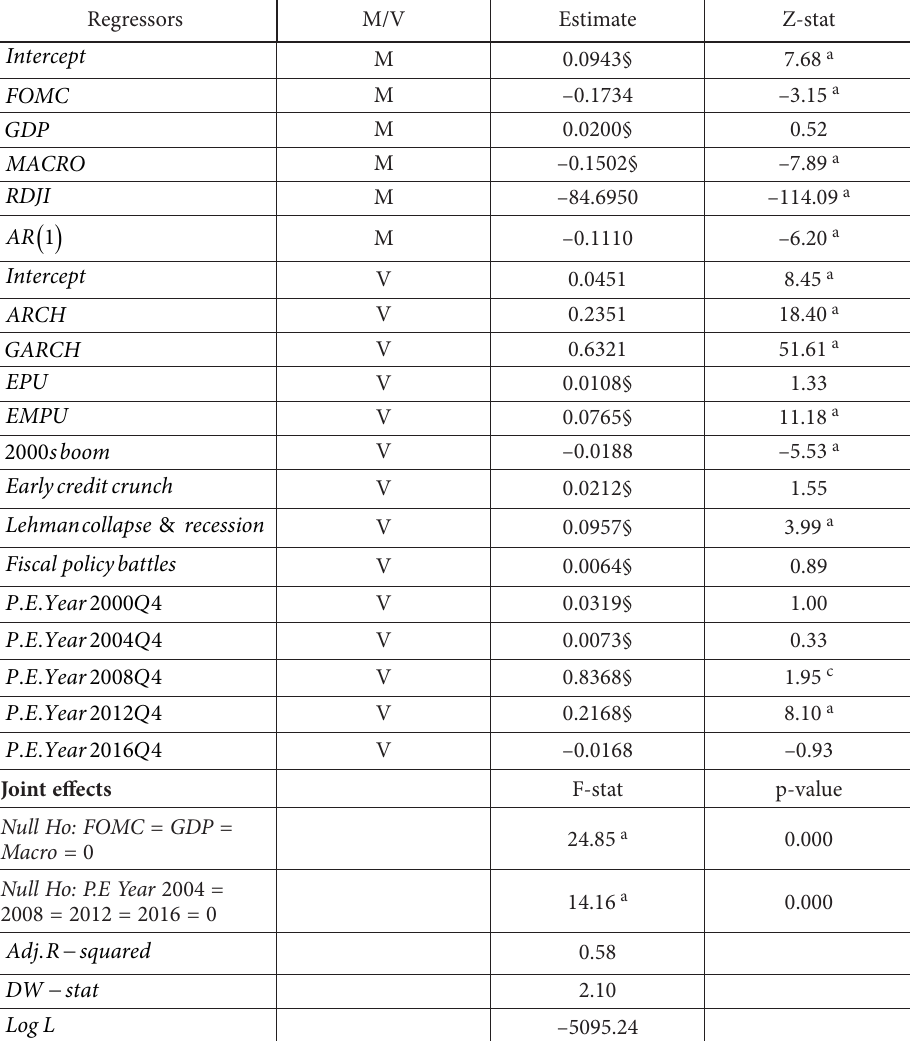
Table 7. Economic policy uncertainty and Dow Jon volatility index